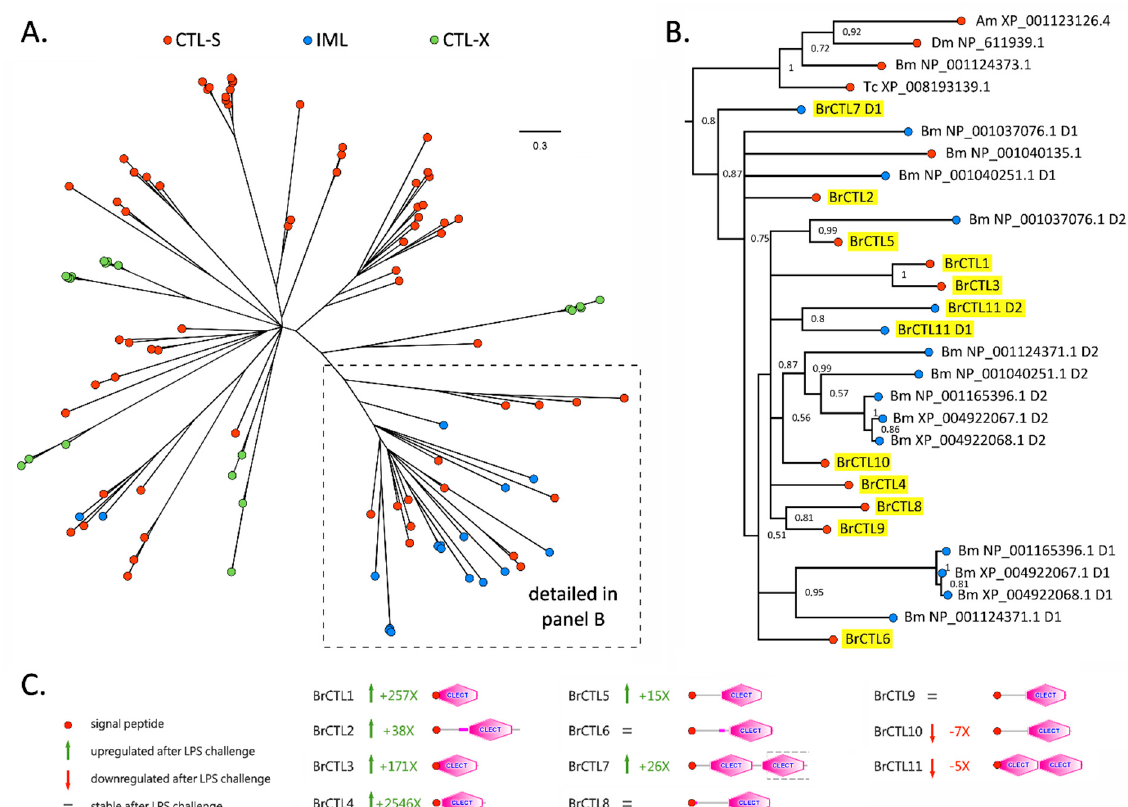
Figure 2. Bayesian phylogeny of insect CTL domain-containing proteins, including representatives from Drosophila melanogaster (Diptera), Tribolium castaneum (Coleoptera), Apis mellifera (Hymenoptera), and Bombyx mori (Lepidoptera), plus the 11 CTLs identified in B. rossius . The full unrooted tree, which depicts the complex evolutionary relationships among the three major structural classes of CTLs (i.e., CTL − S, IML, and CTL − X) is displayed in panel ( A ). The branch that includes all B. rossius CTLs (highlighted with a yellow background) are detailed in panel ( B ). The numbers shown close to each node represent posterior probability support values. Poorly supported nodes (i.e., <0.5) were collapsed. Dm: D. melanogaster ; Am: A. mellifera ; Tc: T. castaneum ; Bm: B. mori . Panel ( C ) reports the domain architectures and gene expression trends following LPS stimulation of B. rossius CTLs. The portion of BrCTL7 included in a dashed box indicates a missing, unassembled region. D1 and D2 indicate the two CLECT domains of